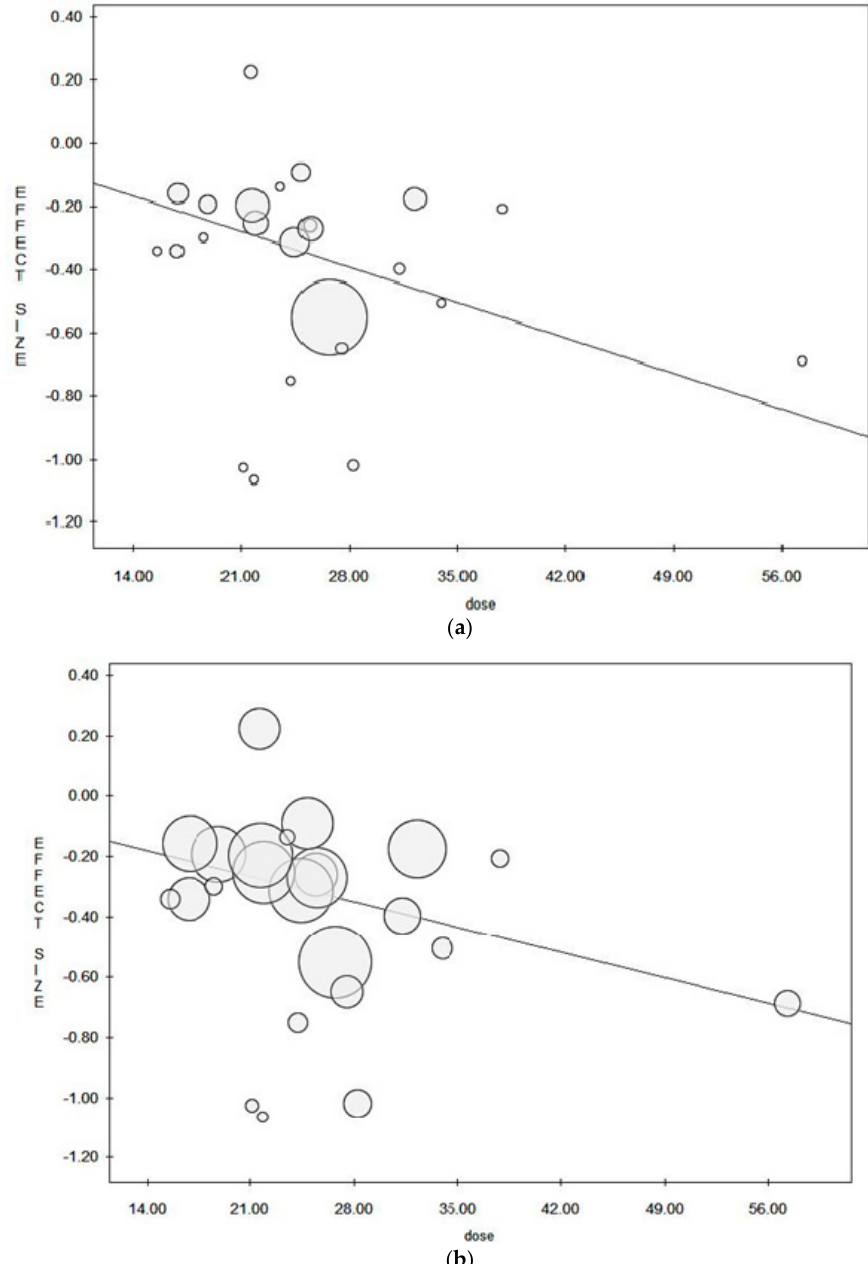
Figure 3. Meta-regression plot for ( a ) fixed effect model and ( b ) random effect model.